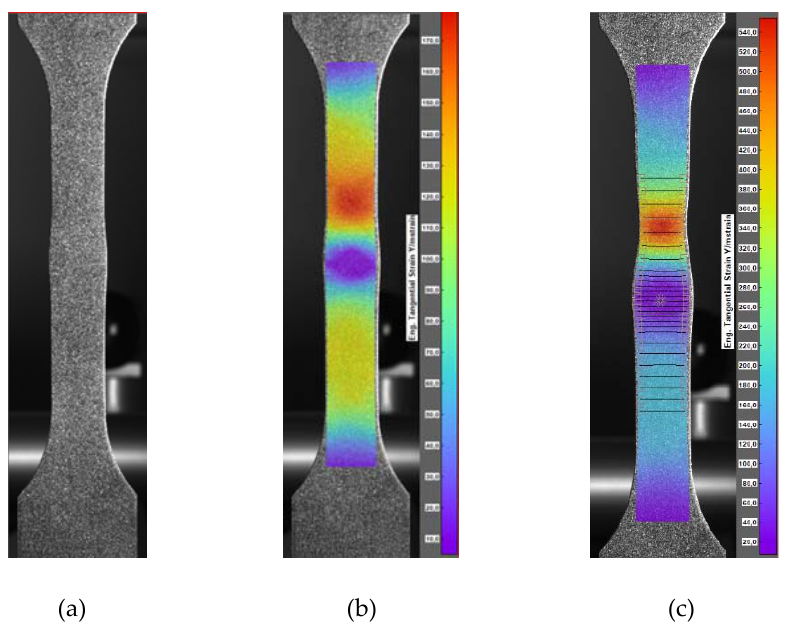
Figure 8. Phases of sample image analysis with the use of Istra 4D software: ( a ) image of the sample with specks, ( b ) image of the sample with the deformation field, ( c ) image of the sample with the deformation field, including lines defining the cross-section planes in which the tension curves were determined.